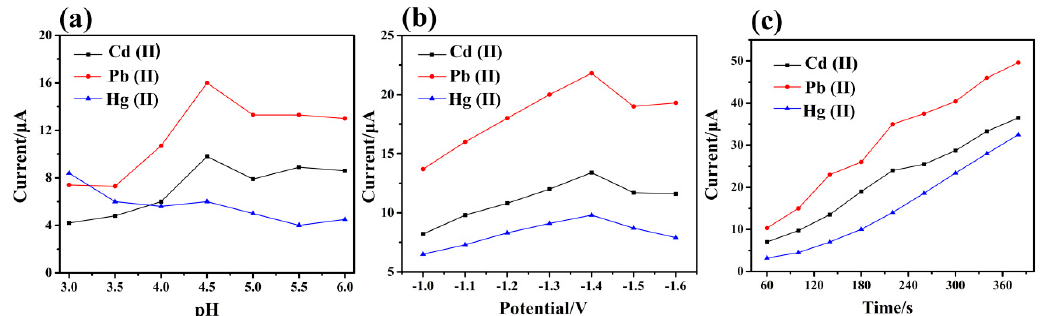
Figure 7. Effects of ( a ) pH values, ( b ) deposition potential ( c ) deposition time on the stripping peak currents of Cd(II), Pb(II) and Hg(II) at PProDOT(MeSH) 2 @Si / GCE (in 0.1 M ABS containing 1.0 µ M of Pb(II), Cd(II) and Hg(II).